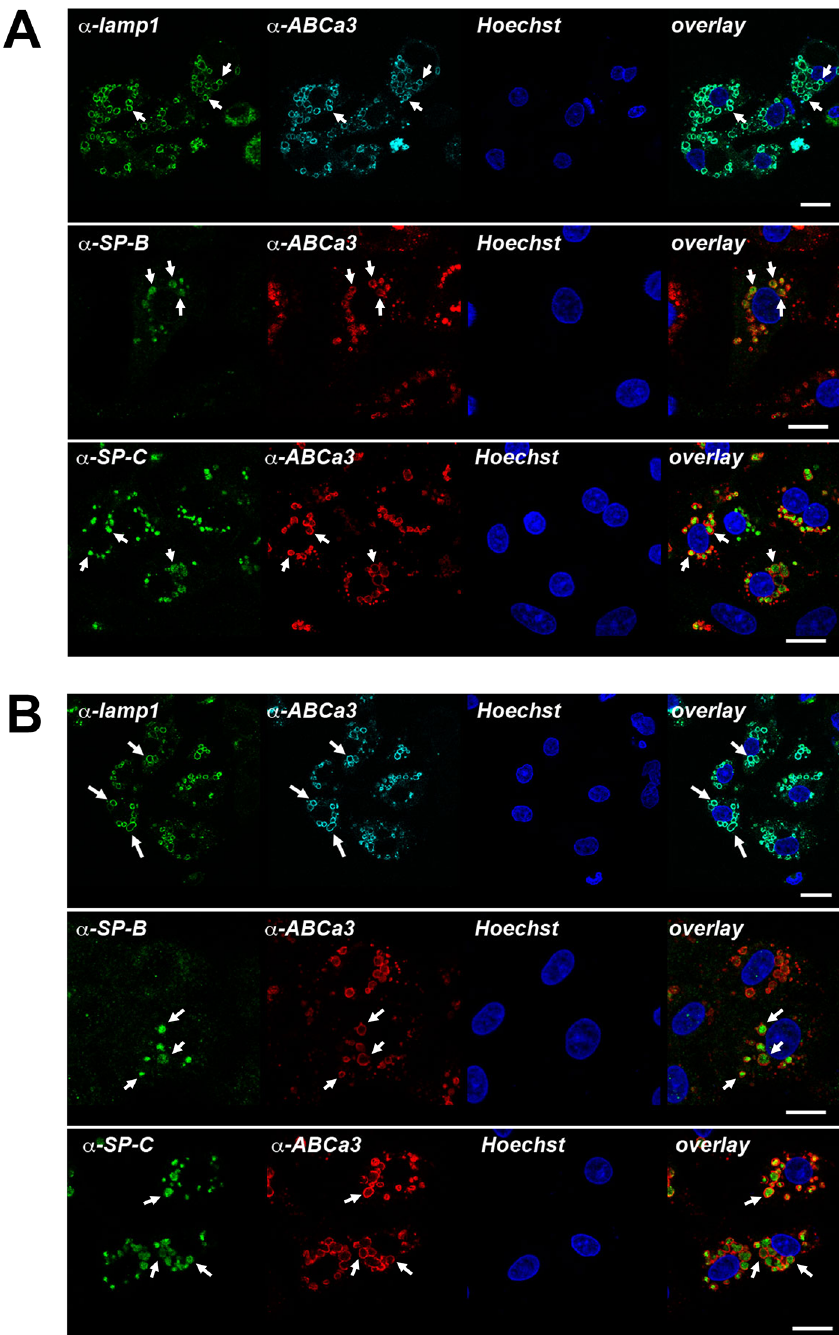
Figure 2. Expression and localization of LB markers are not affected by LRRK2 -/-. Immunocytochemical localization of Lamp1, ABCa3, and surfactant proteins SP-B and SP-C in ATII isolated from LRRK2 -/- rats (A) and ATII cells isolated from wt rats (B). Lamp1 and ABCa3 localized to LB limiting membrane, whereas SP-B and SP-C are inside the vesicle together with the lipid component of surfactant. No obvious differences in localization of these markers in cells isolated from KO and wt rats were observed. Arrows indicate individual LBs in type II cells. Scale bar=10 m